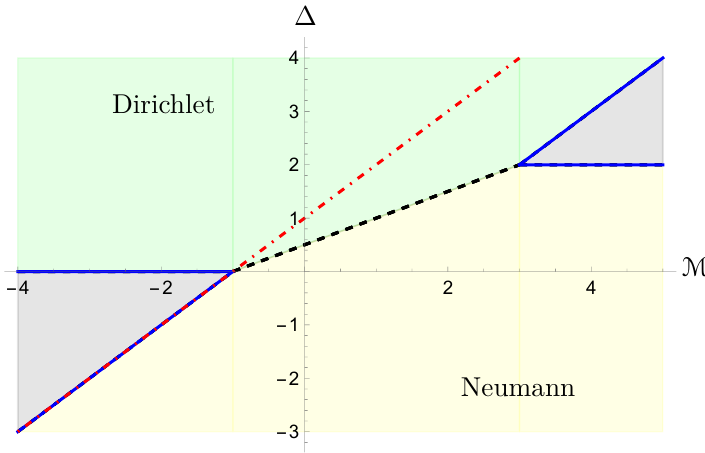
Figure 2 . We illustrate the features of the models we consider in the two-dimensional ( M , ∆) parameter space. The Dirichlet and Neumann boundary conditions are separated across the locus ∆ = 1+ M , indicated by the dashed black line. The gray regions correspond to domains where the 2 lowest quasinormal mode is unstable at low momenta. At its boundary indicated by the blue lines, we encounter the existence of diffusive modes, analogous to the hydrodynamic modes encountered for higher dimensional black holes. We have also indicated the massless case, whence ∆ = M + 1 , which we note is always stable in the Dirichlet regime and has hydrodynamic behaviour in the Neumann